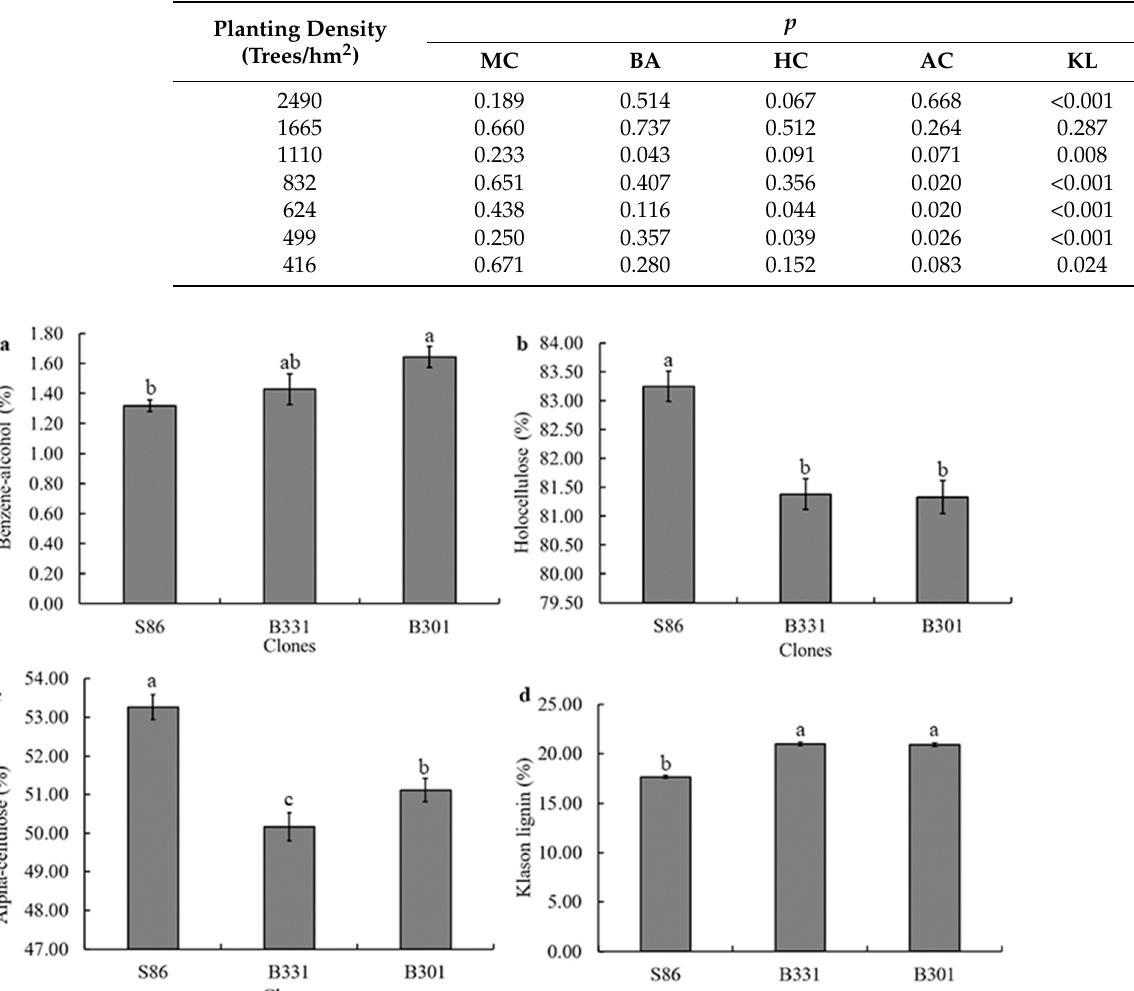
Table 4. Analysis of variance results for the moisture content and four chemical components of the 11-year-old triploid Chinese white poplar plantation within each initial planting density group.